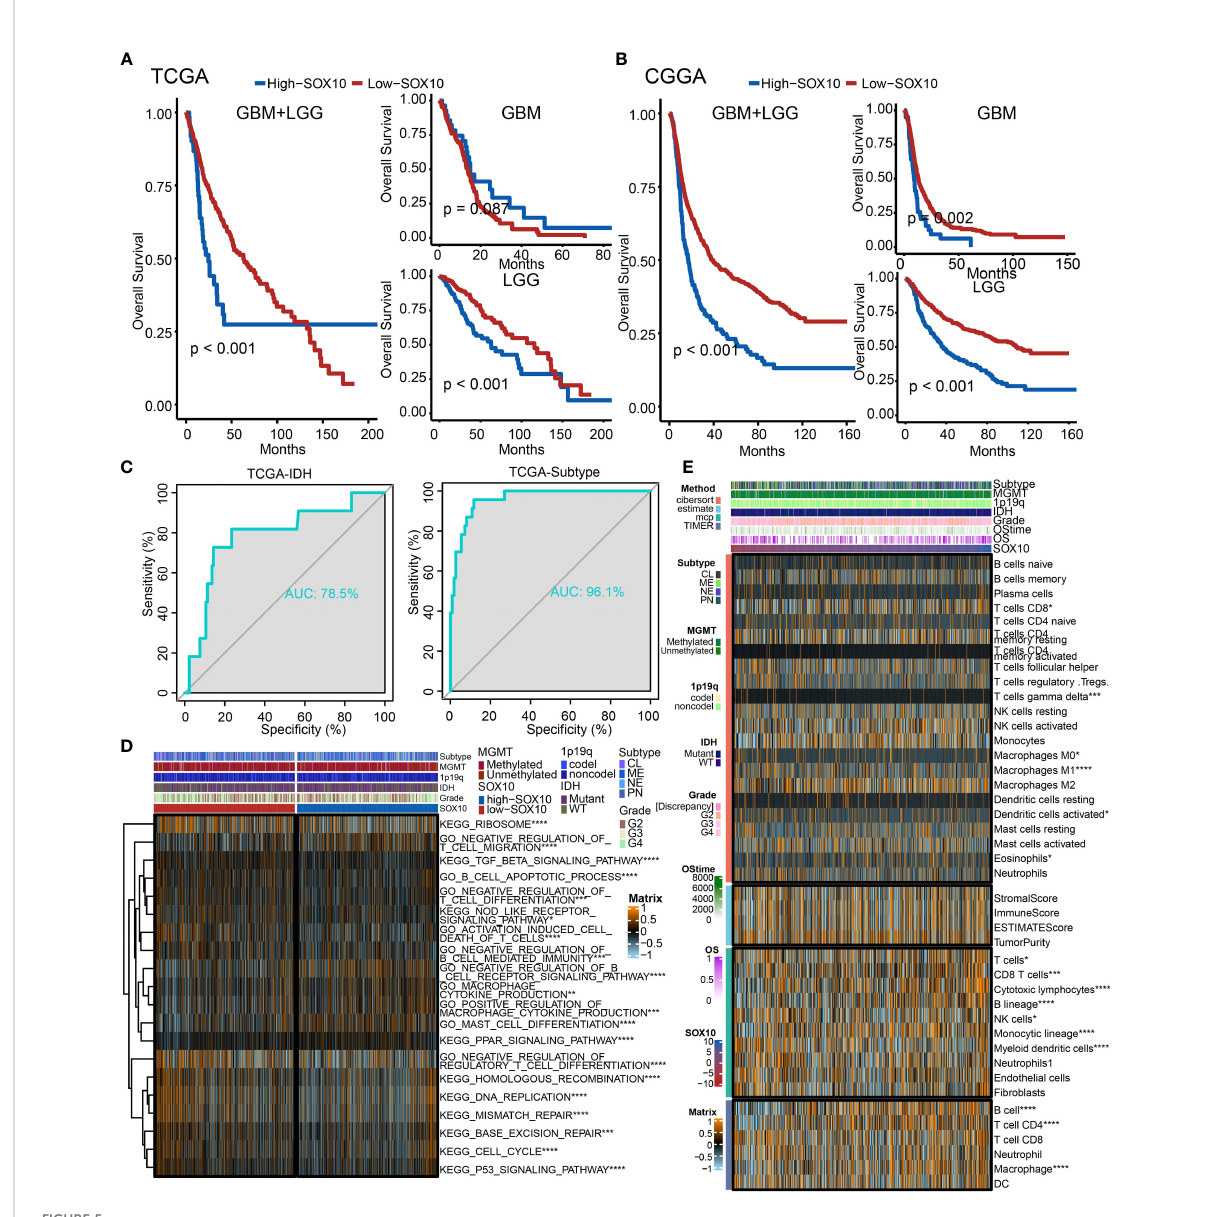
FIGURE 5 The prognostic potential of SOX10. Kaplan – Meier overall survival analysis of SOX10 in GBM, LGG, and pan-glioma based upon the (A) TCGA and (B) CGGA datasets. (C) Predictive value of SOX10, IDH, and subtype measured by ROC curves in TCGA dataset. (D) The heatmap for gene set variation analysis of SOX10 from TCGA. *p < 0.05, **p < 0.01, ***p < 0.001, ****p < 0.0001. (E) Heatmap visualized the abundance of in fi ltrating immune cell groups with divergent SOX10 degree. *p < 0.05, **p < 0.01, ***p < 0.001, ****p <